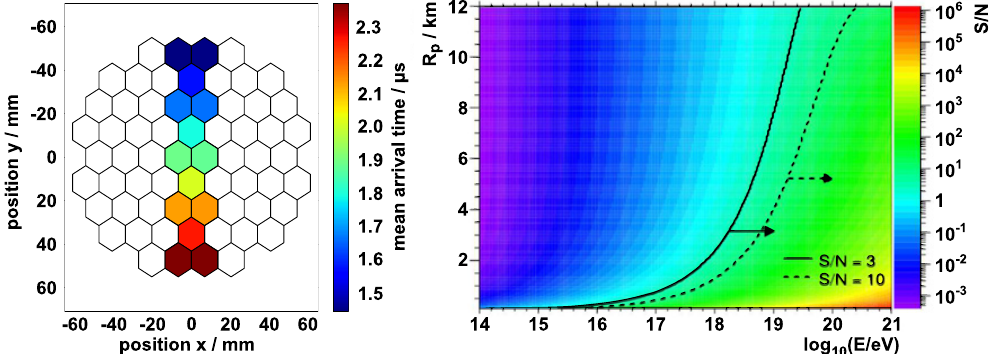
Figure 4. Left : simulated event viewer: Each hexagon represents one camera pixel. The signals within white pixels do not exceed a certain threshold. Color-coded is the arrival time of the fluorescence light within a pixel. Air shower energy E = 10 18 eV, distance to telescope R p = 2km. Right : simulated signal-to-noise ratio (S/N) as function of the energy of an air shower and its distance to the telescope. The noise is dominated by the rather bright night-sky in Aachen, Germany used in this simulation. If e.g. a S / N > 3 is desired a 10 18 eV air shower is visible up to a distance of approximately 2km. Lines of constant S/N will shift to the left for larger telescope apertures or more efficient SiPMs in combination with a smaller field-of-view of the pixels as well as for darker observation sites.